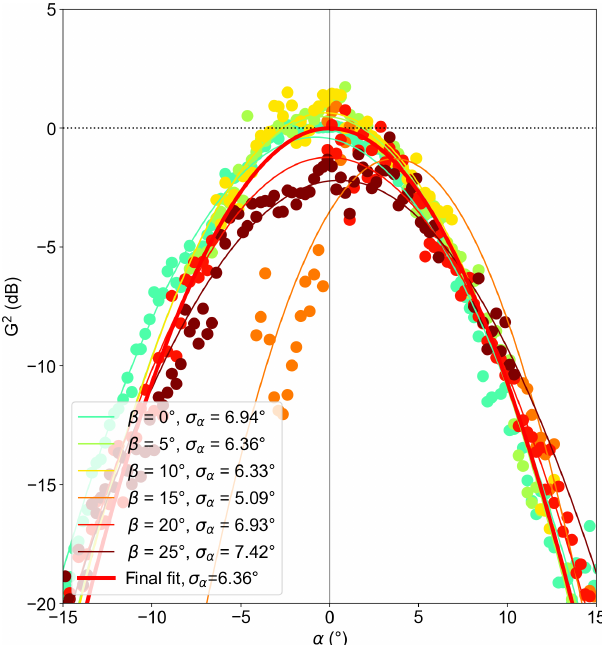
Figure B2. Reconstructed azimuth dependence of nadir return power for different incidence angles. For each incidence angle, the α = 0 value has been used as a reference. The thick line shows the final Gaussian fit used in the data analysis. The β = 15 ◦ data were excluded from the